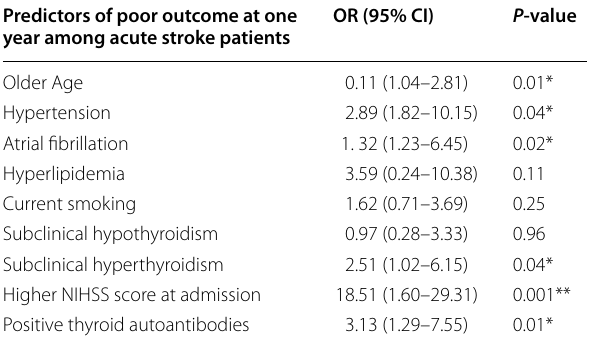
Table 3 Multiple regression analysis for predictors of